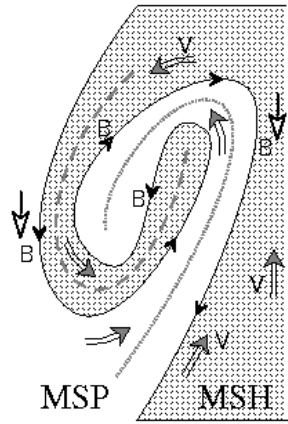
Fig. 2. Illustration taken from Nykyri and Otto (2001) of a KHI vortex causing mixing at the MSP/MSH boundary